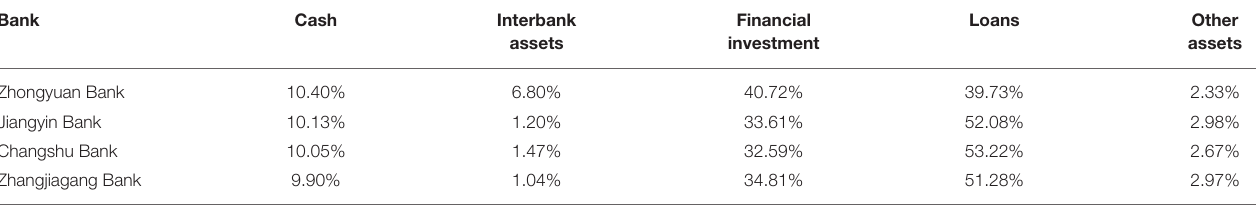
TABLE 2 | The proportion of various assets held by banks in the total assets of banks. Bank